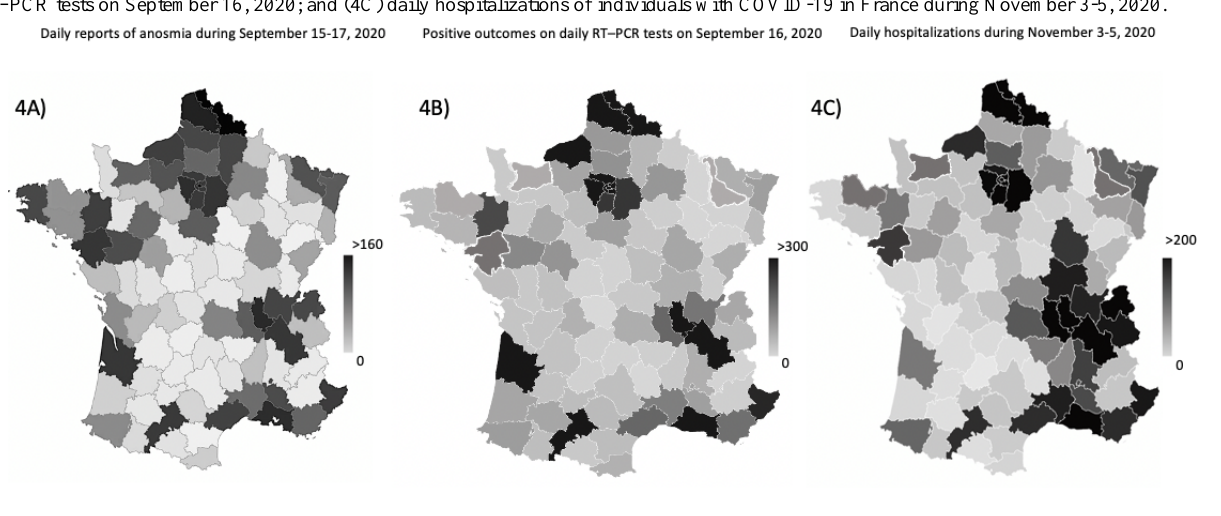
Figure 4. Maps displaying the correlation between daily reports of anosmia with COVID-19–related hospitalizations during the second wave of the pandemic in France. The cumulative number of (4A) daily reports of anosmia during September 15-17, 2020; (4B) positive outcomes on large-scale RT–PCR tests on September 16, 2020; and (4C) daily hospitalizations of individuals with COVID-19 in France during November 3-5,